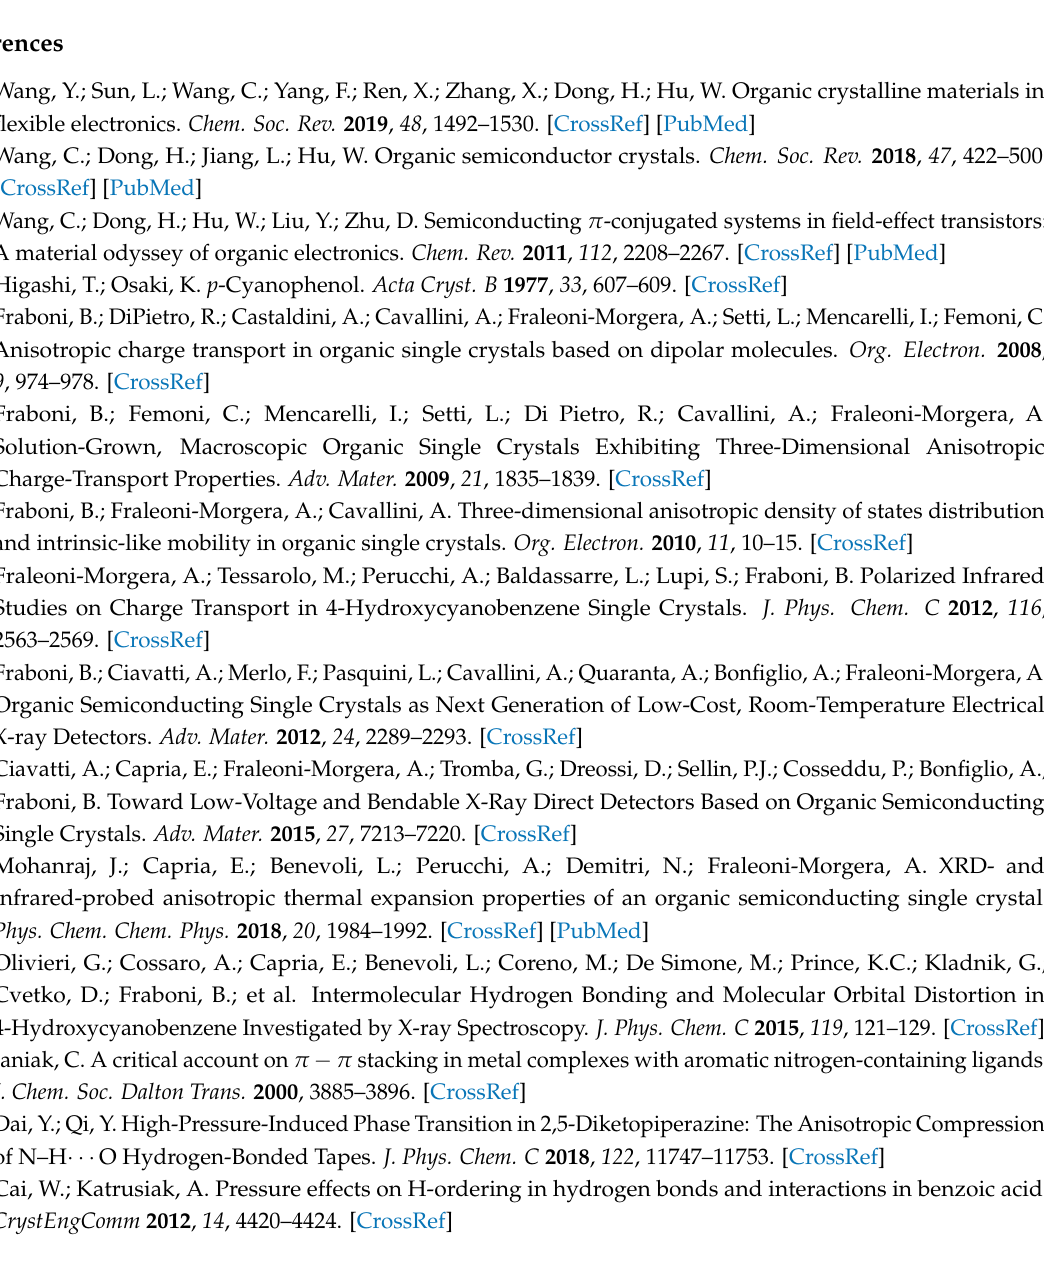
Supplementary Materials: The following are available online, Figure S1: Calculated compressibilities, Figure S2: Voids calculated in Mercury. Figure S3: Angles between the benzenic ring normal and the centroid–centroid vector for 4HCB compressed in He, Figure S4: Angles between the benzenic ring normal and the centroid–centroid vector for 4HCB compressed in Ne, Figure S5: Volume discontinuities for the transitions in He, Figure S6: Volume discontinuities on the transitions in Ne, Table S1: Variable-pressure lattice parameter data for compression in He, Table S2: Variable-pressure lattice parameter data for compression in Ne. The pressure-dependent structures of 4HCB in both He and Ne loadings have been deposited to the CCDC with the numbers 1905777–1905833, and cif files are also provided as